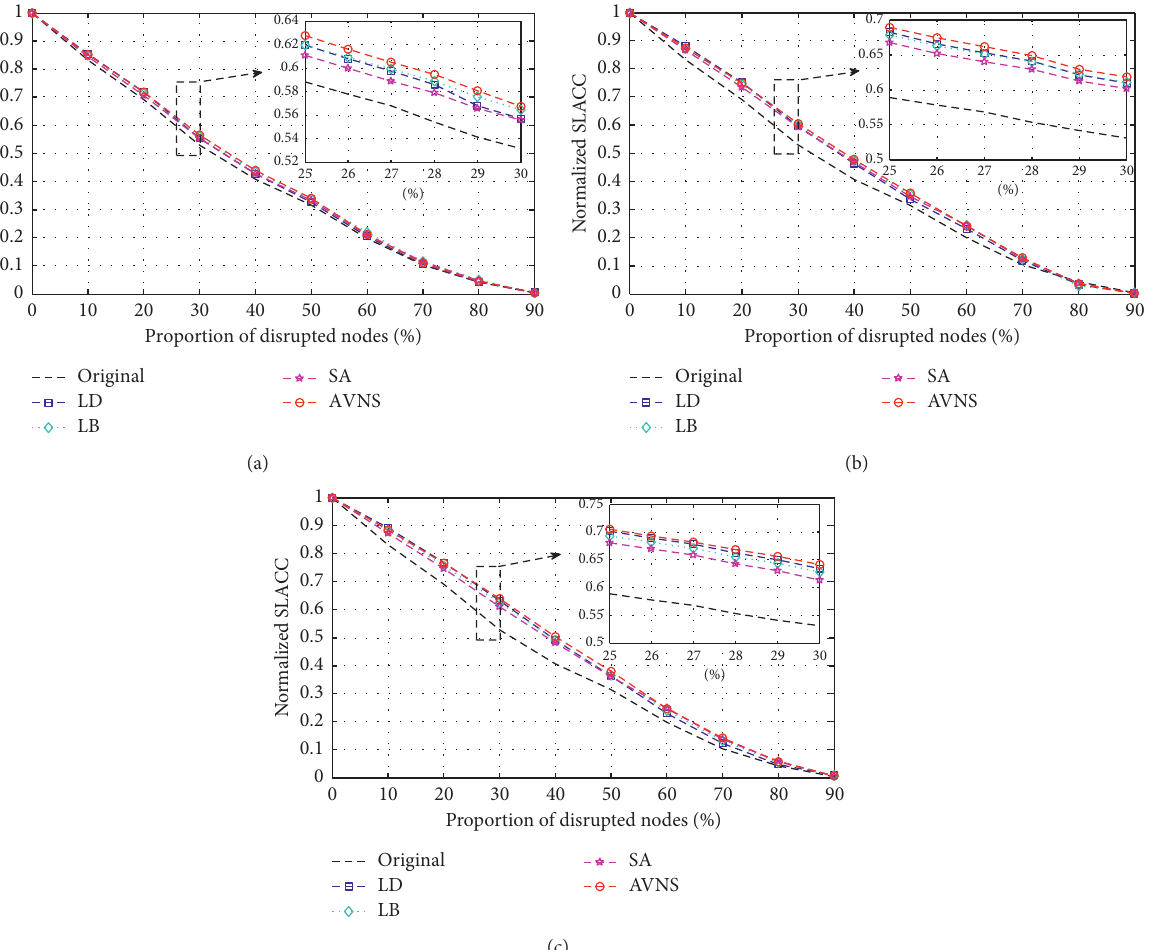
Figure 10: Response of chain 25 and reconfigured ones facing random disruptions. (a) f